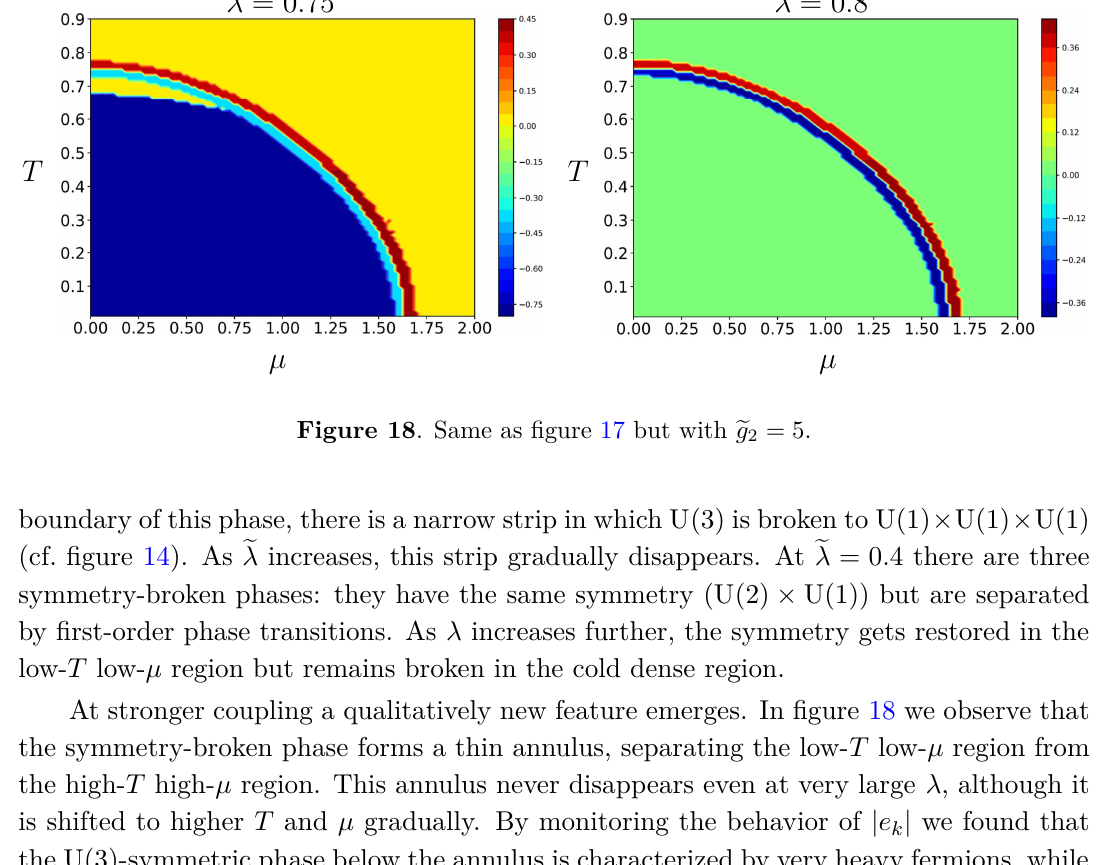
Figure 18 . Same as figure 17 but with